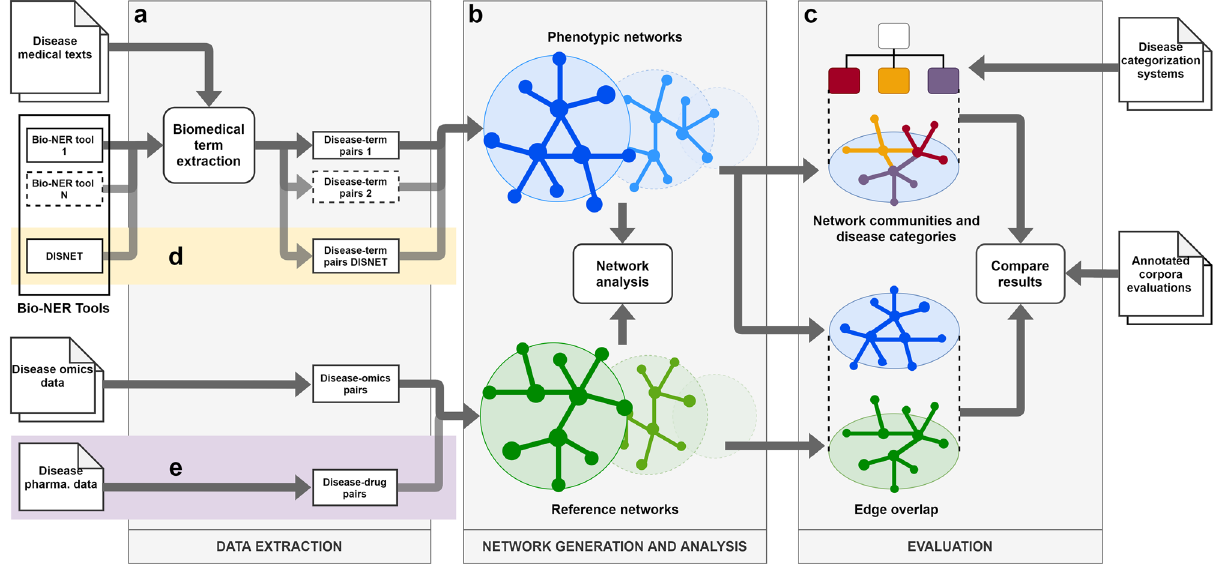
Figure 1. Experimental Design. ( a ) First, data are extracted from textual and omics sources; ( b ) next, networks are generated from the extracted data, and their main characteristics are analysed and compared; ( c ) finally, network-based criteria are applied to evaluate the accuracy of the bio-NER tool, and the results are compared with existing evaluations based on annotated corpora; ( d ) same method is applied to DISNET’s bio-NER system; and ( e ) the reference set is extended with pharmacologic